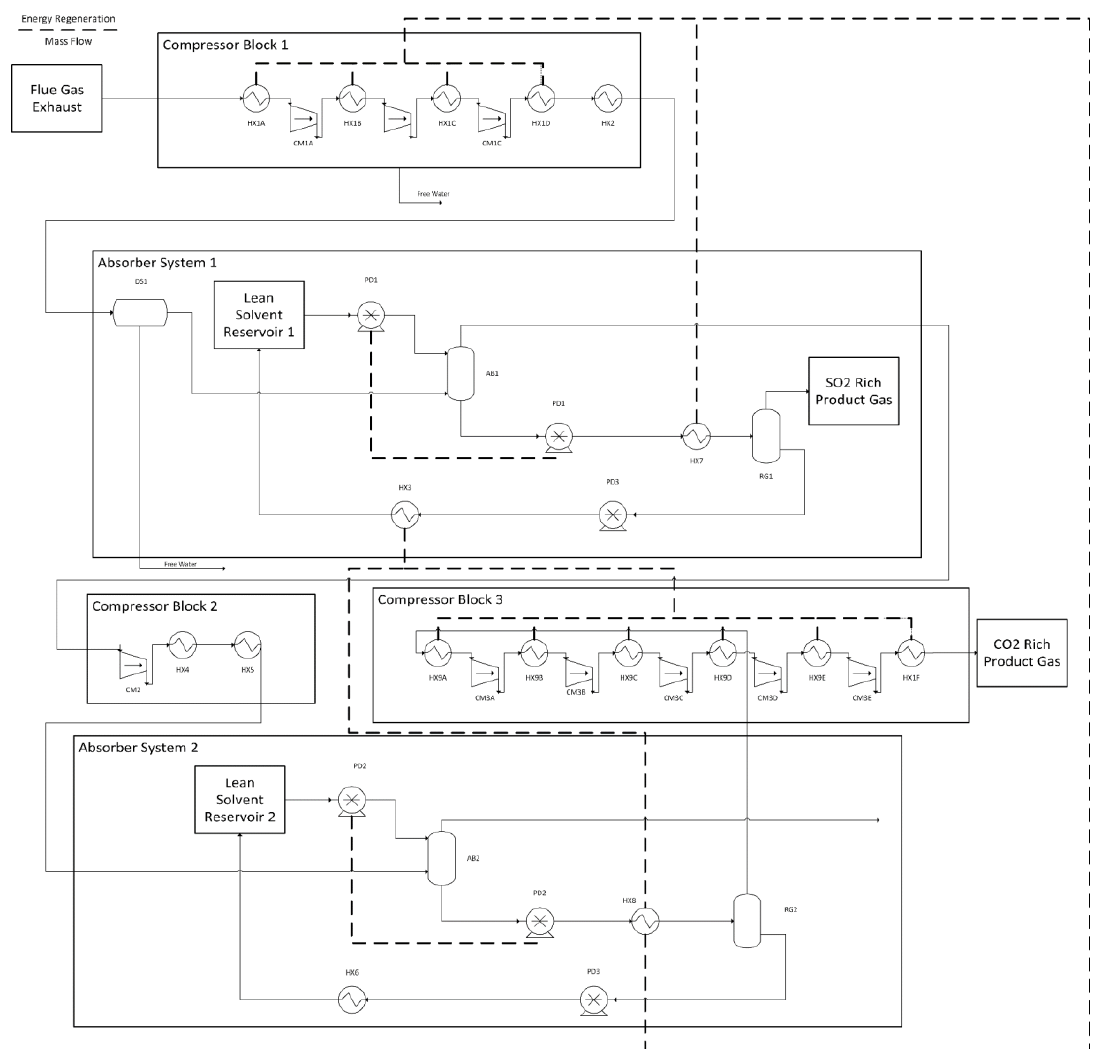
Figure 2. Process diagram for CO 2 and SO 2 capture using a two-stage absorption system.